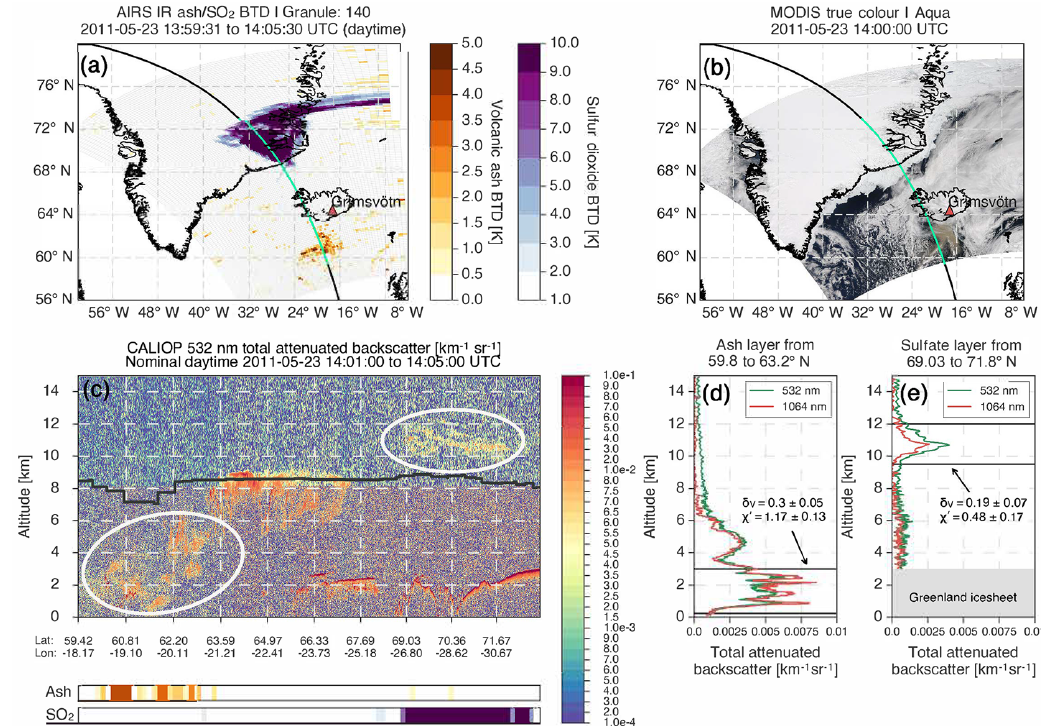
Figure 6. (a) AIRS brightness temperature difference for volcanic ash (yellow/orange/red) and AIRS brightness temperature difference for SO 2 (shades of blue). The ascending trace (travelling from south to north) of the CALIPSO satellite is indicated by the black and green line, in which the green-coloured portion of the line indicates the region of overlap between the CALIOP and AIRS image data. (b) MODIS/Aqua true-colour image showing the low-level ash cloud (brown). (c) CALIOP backscatter curtain for 532nm light with the ash and sulfate layers indicated by the white-coloured ellipses. The lower strips show temperature differences based on the AIRS data indicating regions affected by ash and SO 2 gas. Panels (d) and (e) show vertical profiles of backscatter for ash and SO 42 − , respectively. δ v is the volume depolarization ratio and χ (cid:48) is the colour ratio. The horizontal black lines in panels (d) and (e) show the height range over which the parameters have been calculated. Date and time of overpass: 23 May 2011,